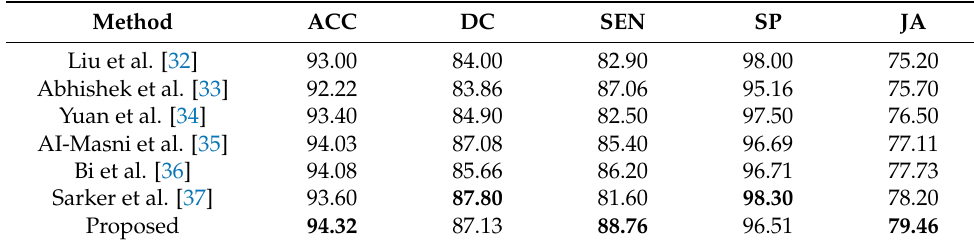
Table 4. Experimental results compared with state-of-the-art methods on ISBI2017 test